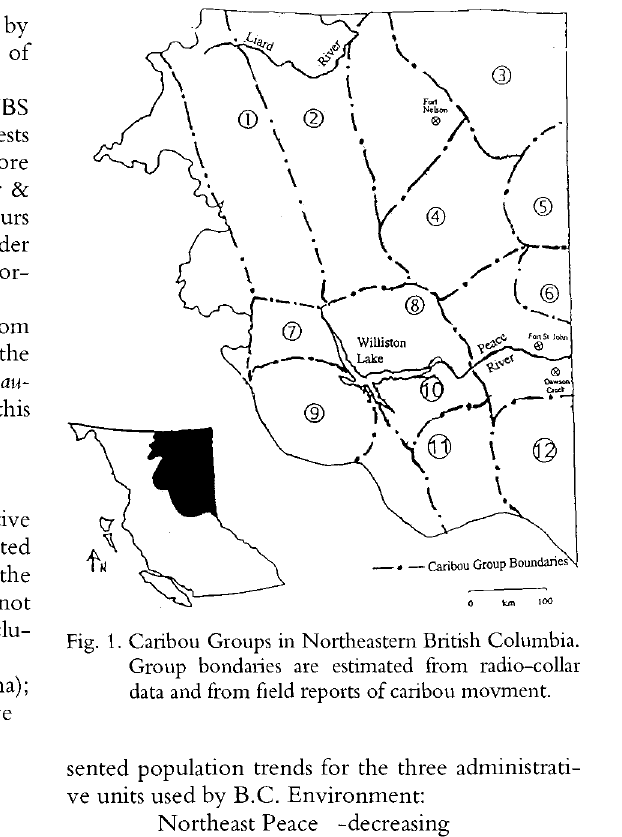
sented population trends for the three